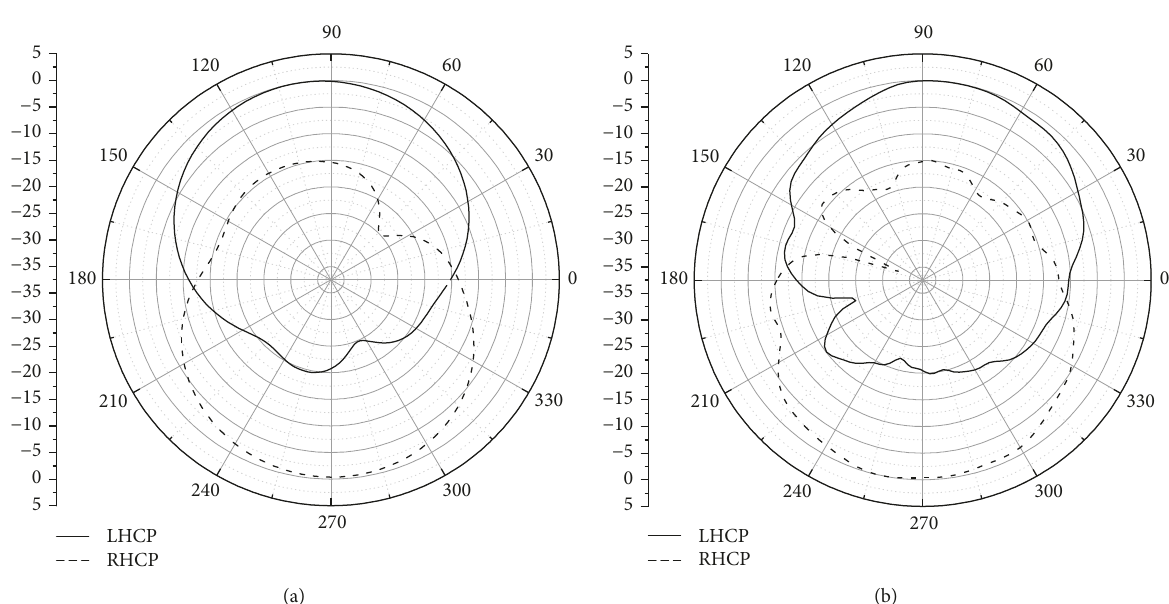
Figure 12: Measured radiation pattern at 2.45GHz: (a) XOZ plane; (b) YOZ